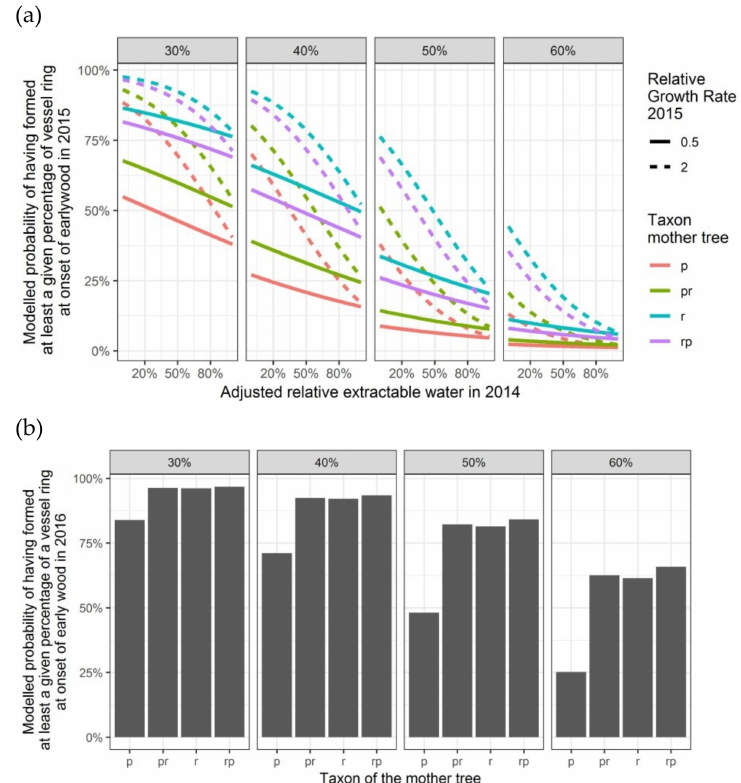
Figure 7. Modelled probabilities for a given level of vessel ring closure at the onset of the earlywood in the second and the third growing season, depending on the taxon of the mother tree and, only for 2015, on the adjusted relative extractable water in 2014 and on the relative growth rate in height in 2015: ( a ) probabilities for having formed 30%, 40%, 50% or 60% of the vessel ring in the second growing season 2015; ( b ) probabilities for having formed 30%, 40%, 50% or 60% of the vessel ring in the third growing season 2016. p: Q. petraea , pr: long stalked intermediate form, r: Q. robur , rp: short-stalked intermediate